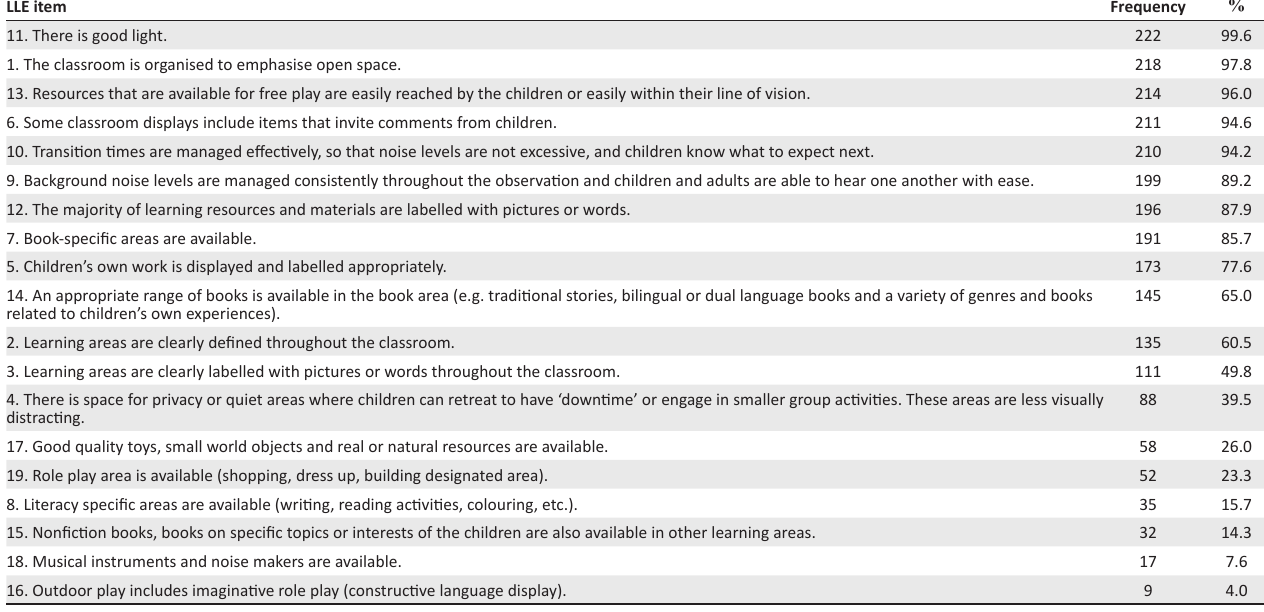
TABLE 1: Number of observations that indicated the presence of each item in the language-learning environment area ( N = 223). LLE item Frequency